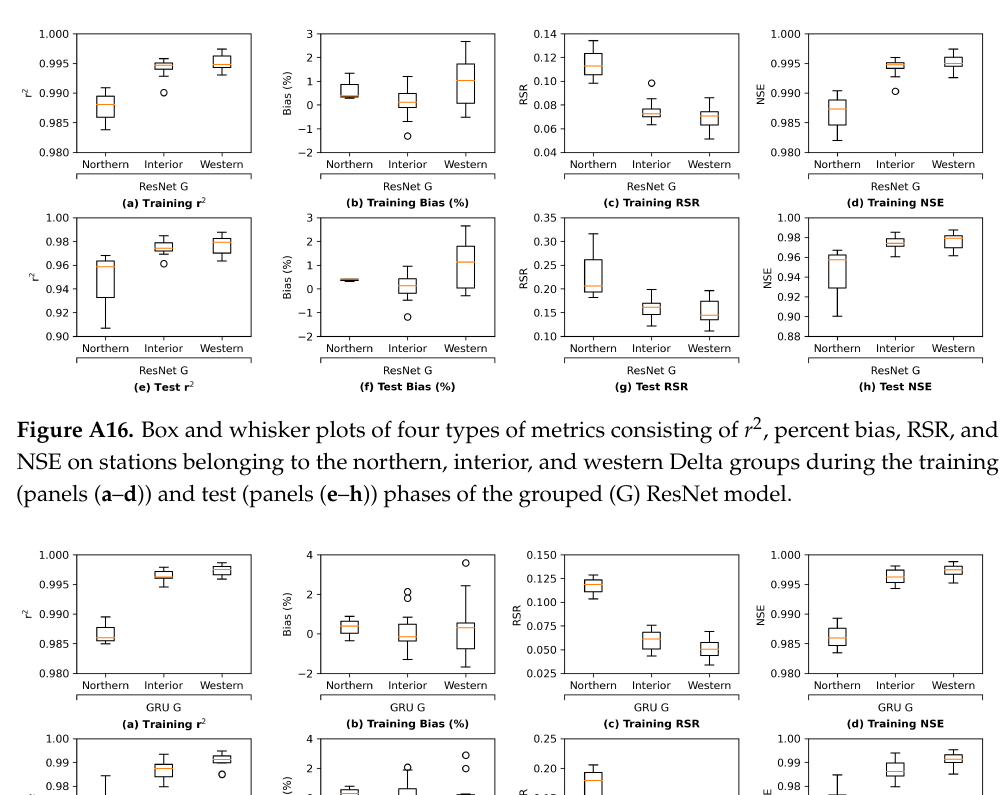
Figure A15. Box and whisker plots of four types of metrics consisting of r 2 , percent bias, RSR, and NSE on stations belonging to the northern, interior, and western Delta groups during the training (panels ( a – d )) and test (panels ( e – h )) phases of the grouped (G) MLP model.